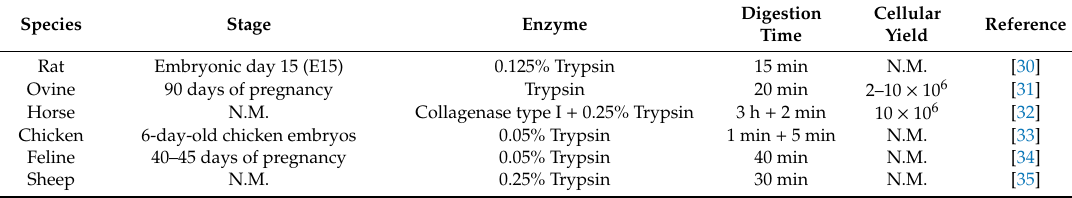
Table 1. Isolation of amniotic epithelial stem cells (AESCs) from di ff erent species. Species Stage Enzyme